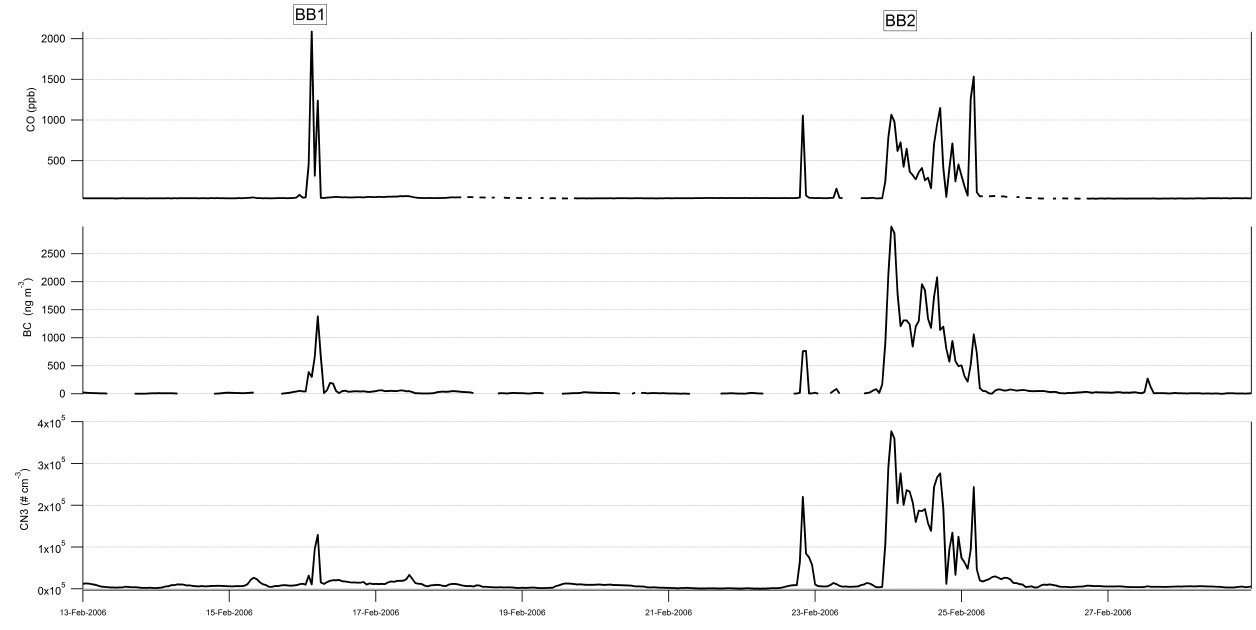
Figure 2. Time series of carbon monoxide (CO), black carbon (BC) and particles > 3nm (CN3) for the study period (BB1 and BB2 shown).